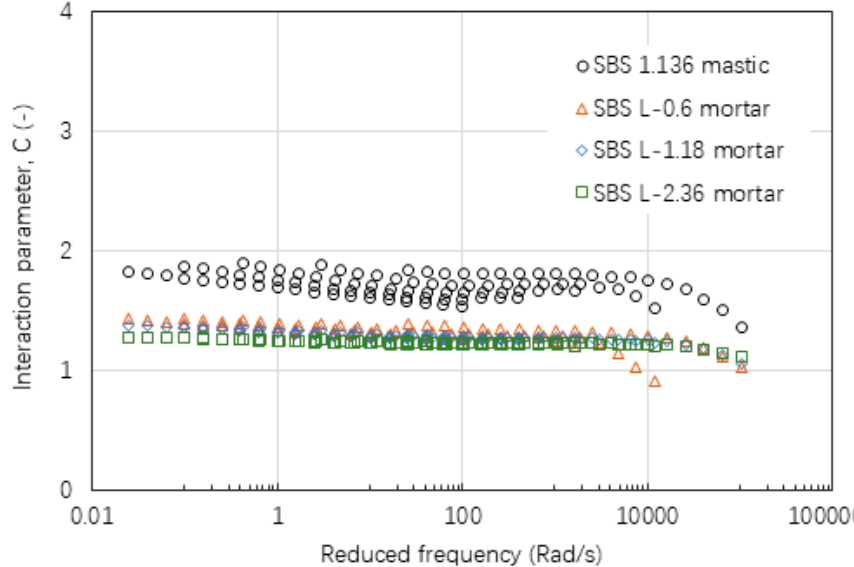
Figure 16. Interaction parameter of C values for asphalt mastic and mortar based on AC ‐ 20 mixture.